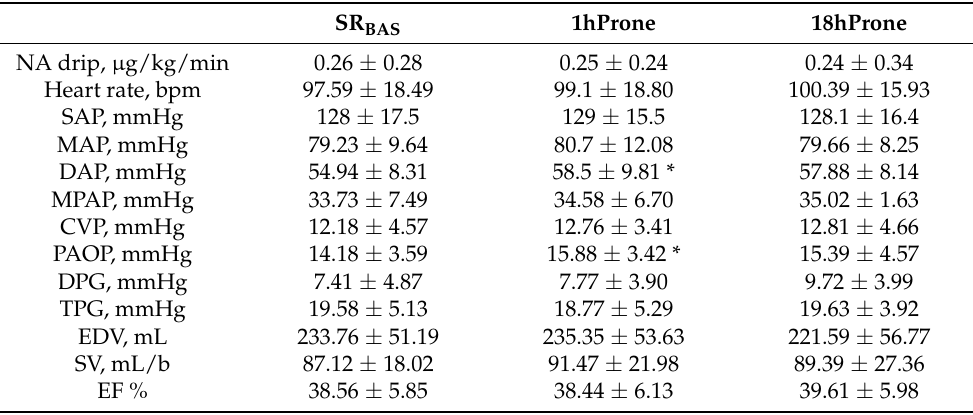
Table 2. Hemodynamic and pulmonary function data at baseline semi recumbent (SR BAS ) posture, at 1 h prone posture (1hProne) and at 18 h prone posture